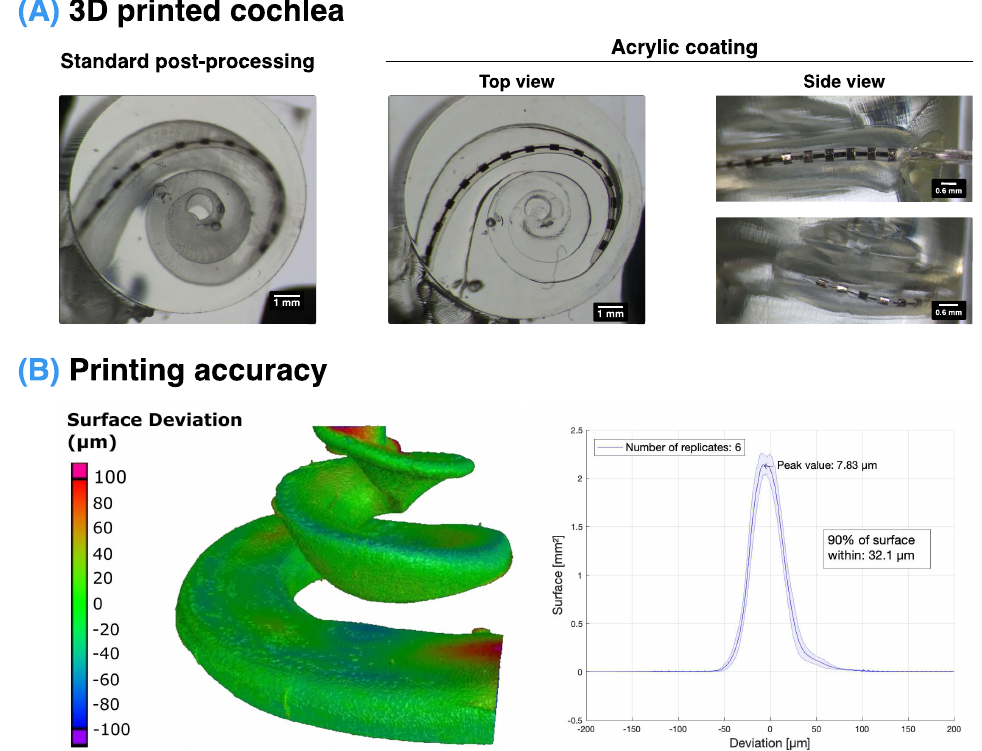
Figure 2. ( A ) Implantation of a CI in ST models with manufacturer-recommended post-processing ( left ) and an additional acrylic coating ( right ). This demonstrates the clear imaging of the CI elec- trodes, vertically and horizontally, to investigate CI positioning and validate the angular insertion depth. ( B ) Quantification of 3D-printing accuracy using nominal–actual analysis demonstrating the 3D map ( left ) and histogram of surface deviation ( right ) compared to the original CAD file used for